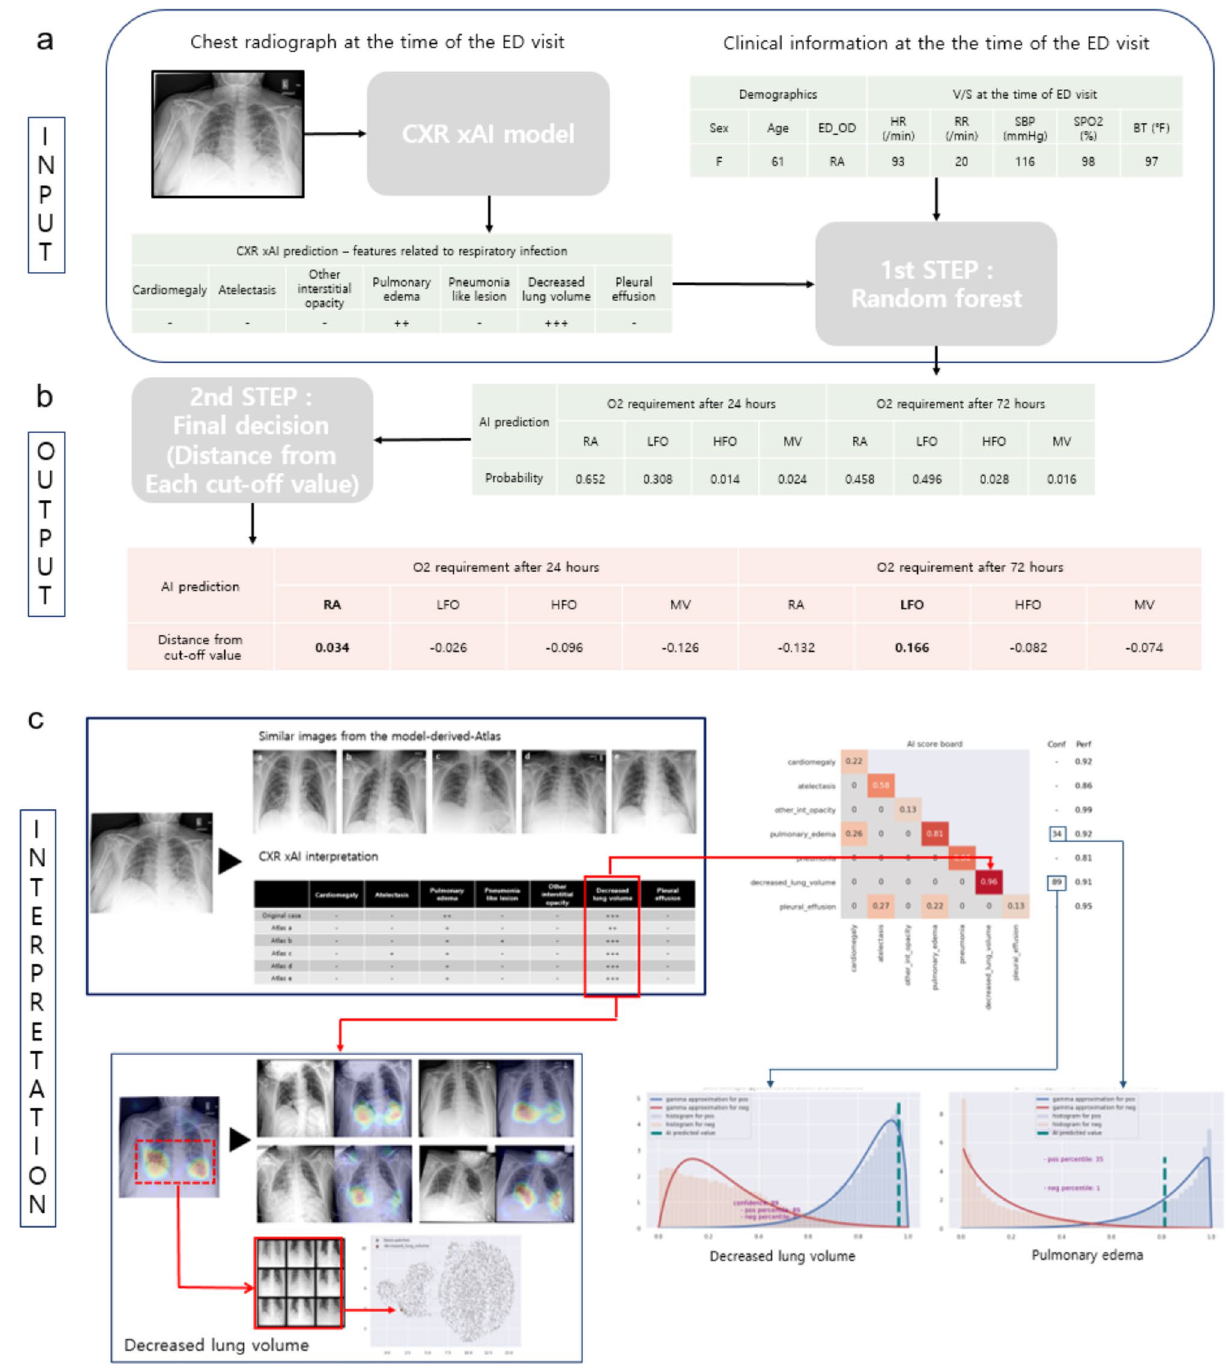
Figure 7. CXR interpretation and AI prediction of most likely stage of oxygen requirement at 24 and 72 h from the time of ED admission in patients with COVID-19. ( a ) Input: For a test case, prediction probabilities for each stage of oxygen requirement at 24 and 72 h from the time of ED admission are derived from the random forest model. ( b ) Output: The stage with the largest positive difference between prediction probability and the cut-off value is selected as the predicted stage of oxygen requirement. ( c ) Interpretation: Prediction probabilities for 7 infection-associated radiographic labels are summarized in the interpretation table and comparable CXRs were selected from the Model-Derived Atlas. Decreased lung volume was identified as a significant feature, based on high prediction probability and calibrated classifier confidence on the AI scoreboard. Feature localization with Grad-CAM and close location on UMAP to the similar feature patches from the Model-Derived Atlas provide visual evidence of decreased lung volume to support the